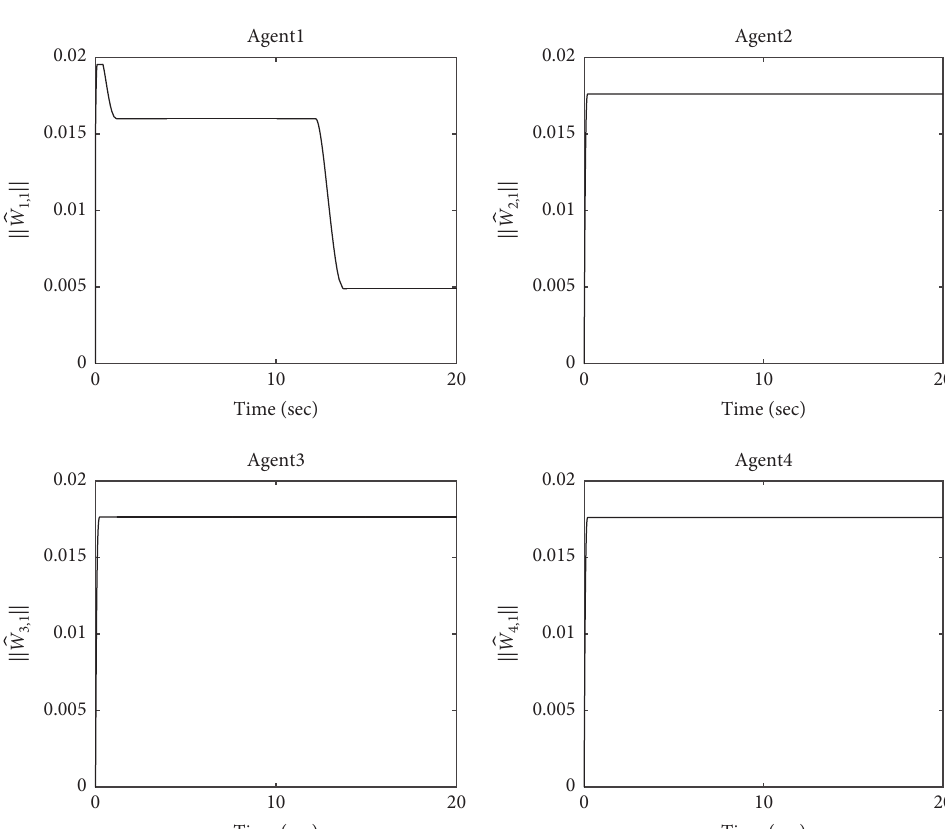
i , 1 ≤ i ≤ 4. i for agent